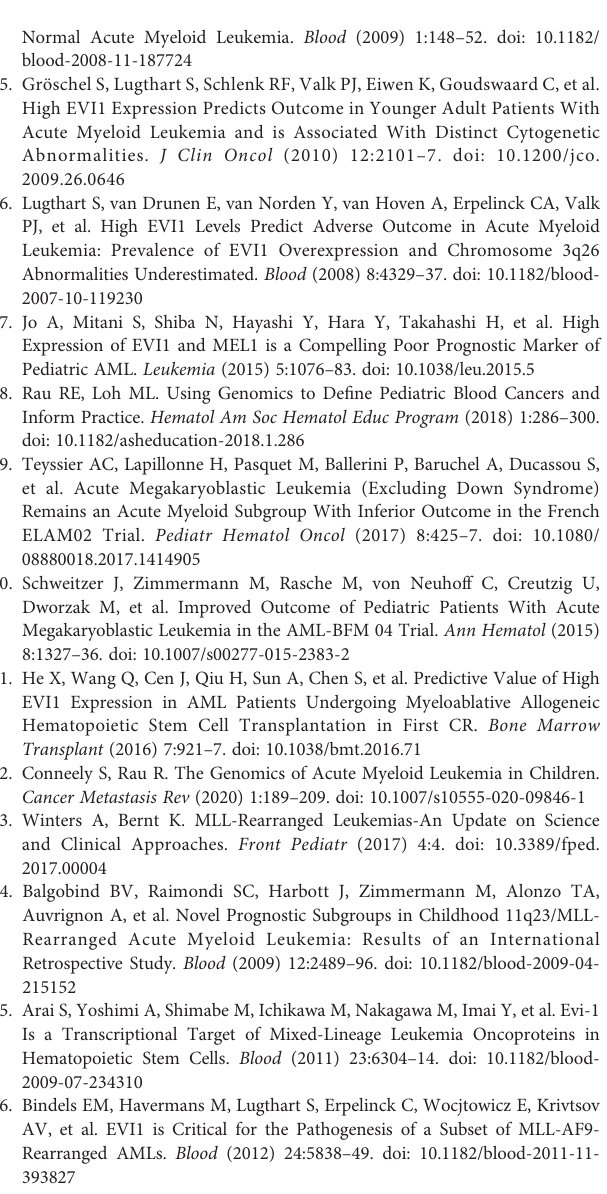
Supplementary Figure 1 | C-HUANAN-AML15 protocol work fl ow. FLAG-IDA: Fludarabine 30 mg/m2/d d2-6, cytarabine 2g/m2/d d2-6, Idarubicin 8 mg/m2/d d4-6, Granulocyte Colony Stimulating Factor (G-CSF) 5 m g/kg/d d1-7. DAE (3 + 10 +5): Daunorubicin 50 mg/m2/d d1,3,5; Cytarabine 100mg/m2 q12h